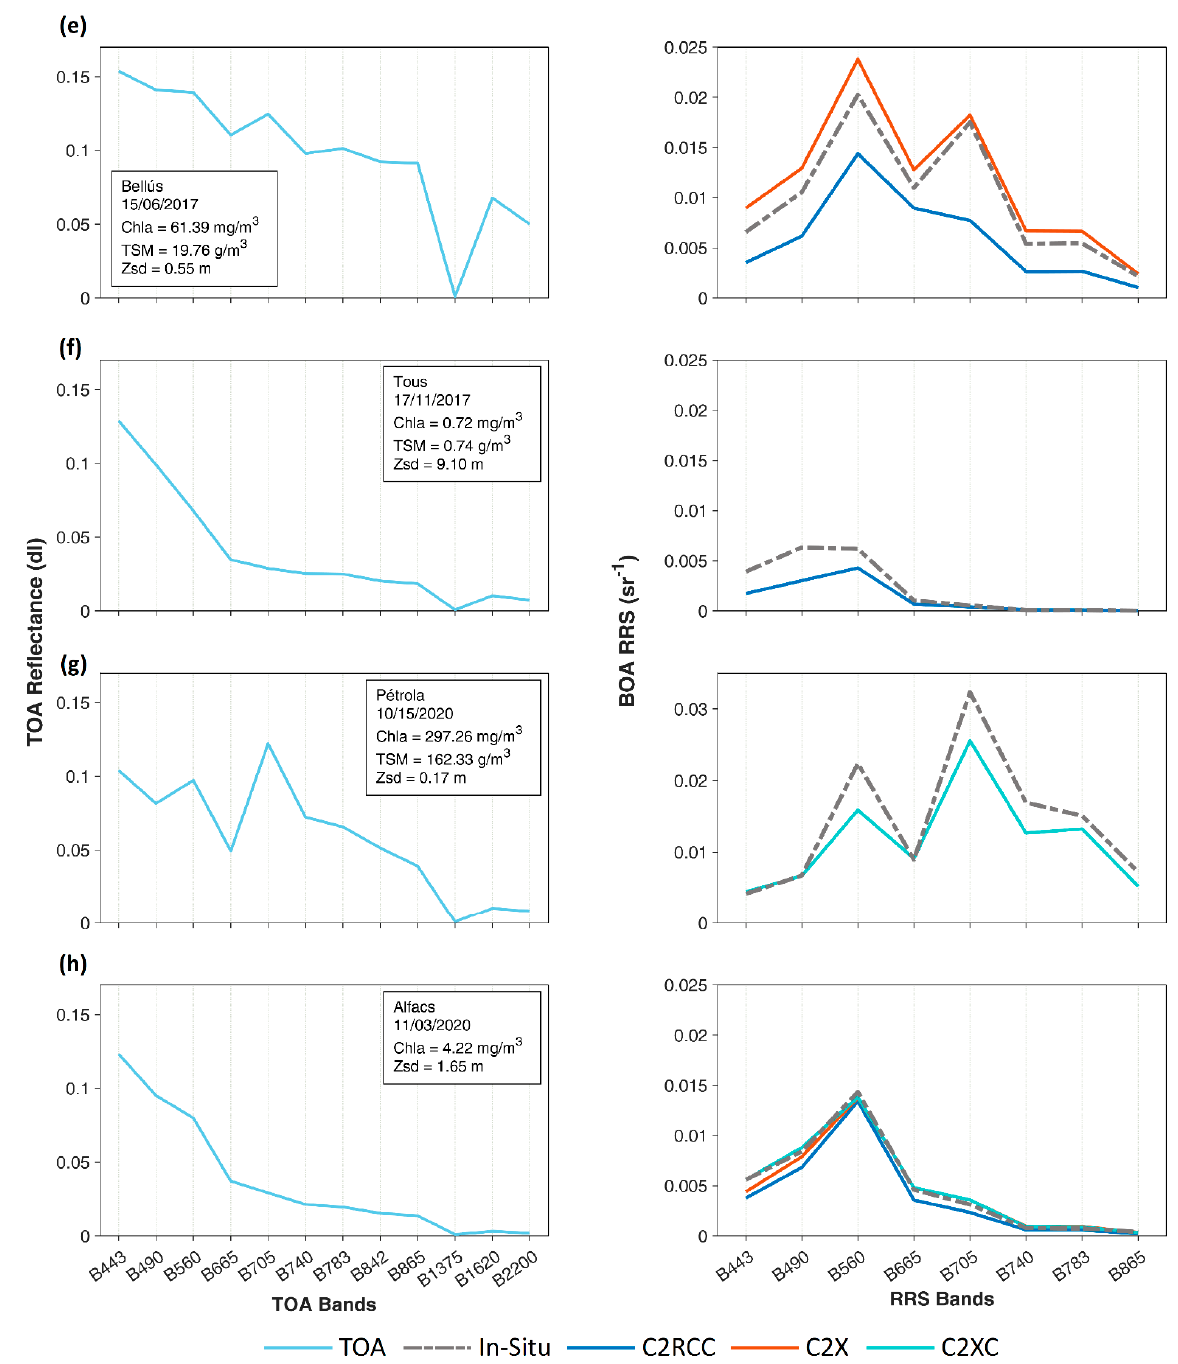
Figure A2. TOA reflectance spectrums (left column) and in situ and C2-Nets estimated Rrs (right column) for different scenarios ( a – h ). Availability of C2-Nets Rrs depends on the pixel flagging criteria described in the paper.